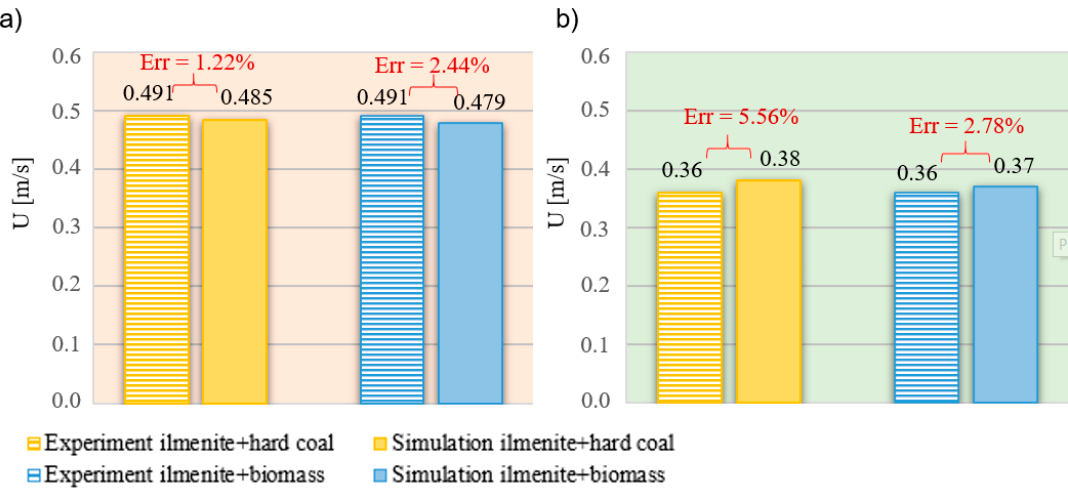
Figure 13. Superficial gas velocity in the bed ( a ) AR ( b ) FR.